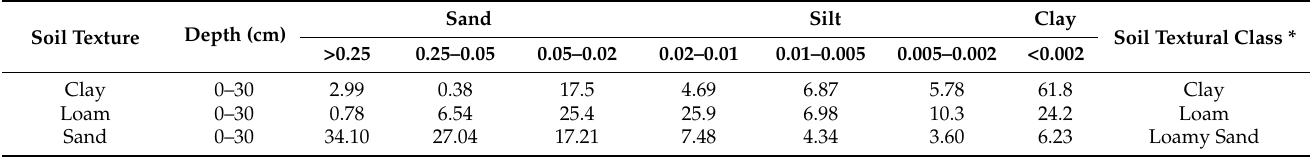
Table 2. Soil texture of sand, loam, and